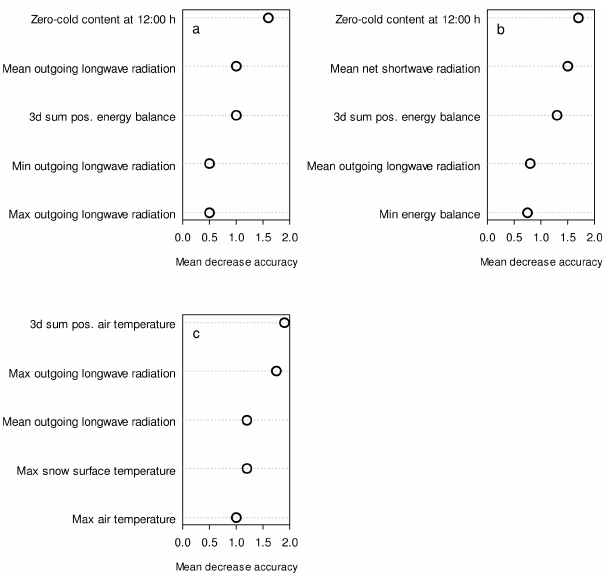
Fig. 3. The five most important variables for RandomForest mod- els built with data obtained from (a) simulated north-facing slopes (2500m, 35 ◦ ), (b) simulated south-facing slopes (2500m, 35 ◦ ), and (c) meteorological parameters recorded at the station Weissfluhjoch to classify wet-snow avalanche and non-avalanche days. Variable importance is based on how much worse the prediction would be if the data for that predictor were permuted randomly; the stronger the decrease in accuracy, the higher is the variable